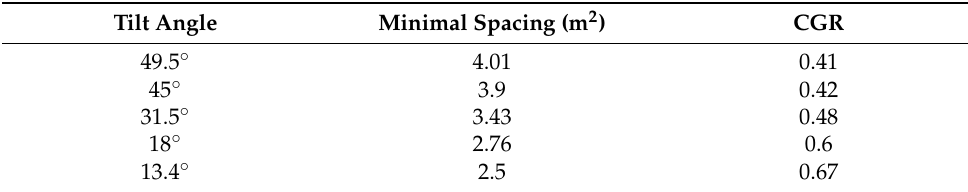
Table 2. Impact of the tilt angle on CGR (Coverage Ground Ratio).